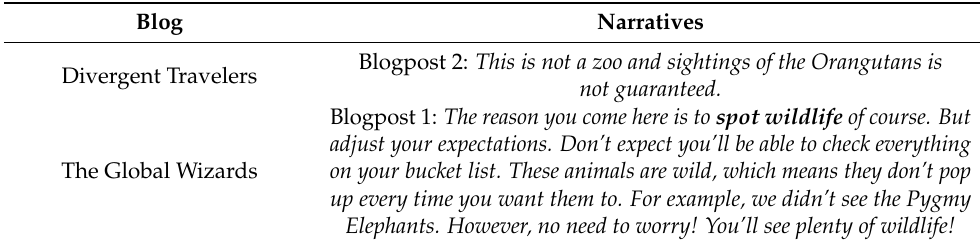
Table 8. Emotional Narratives on Theme